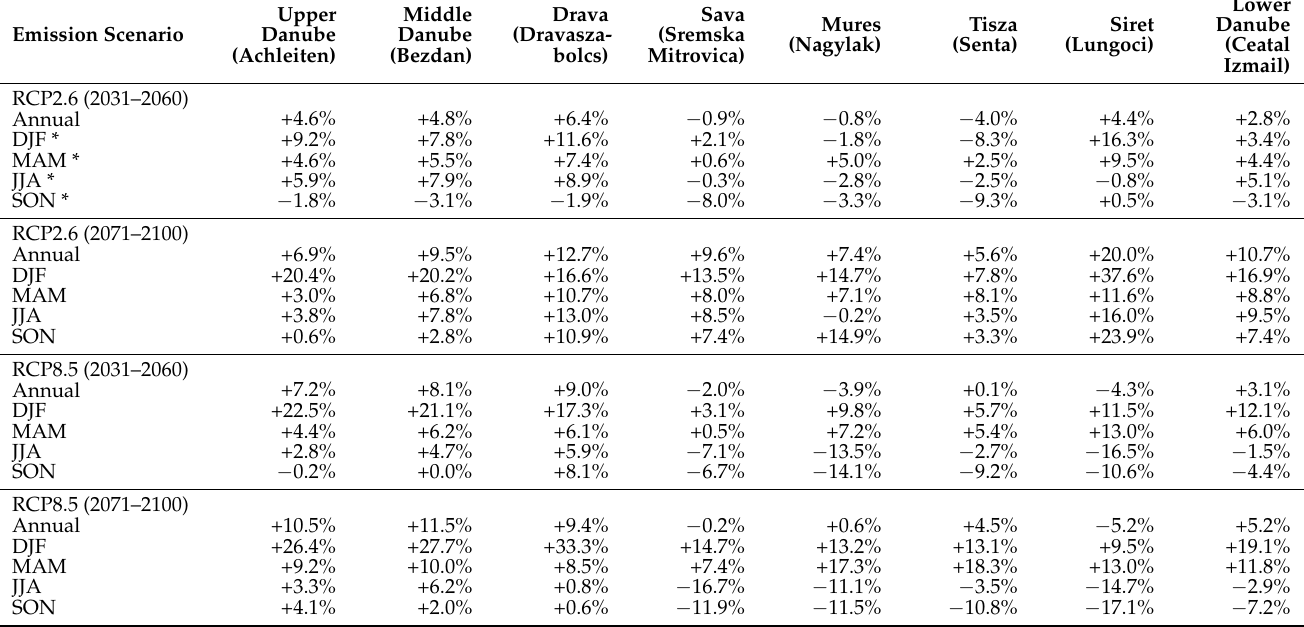
Table 3. Changes in the long-term mean annual and seasonal mean discharge (MQ) [%] in the Danube River Basin and its major sub-basins (at respective gauges in parentheses) according to the GCM-RCM-driven simulations (ensemble mean) under RCP2.6 and RCP8.5 for the near future (2031–2060) and the far future (2071–2100) compared to the historical GCM-RCM-driven